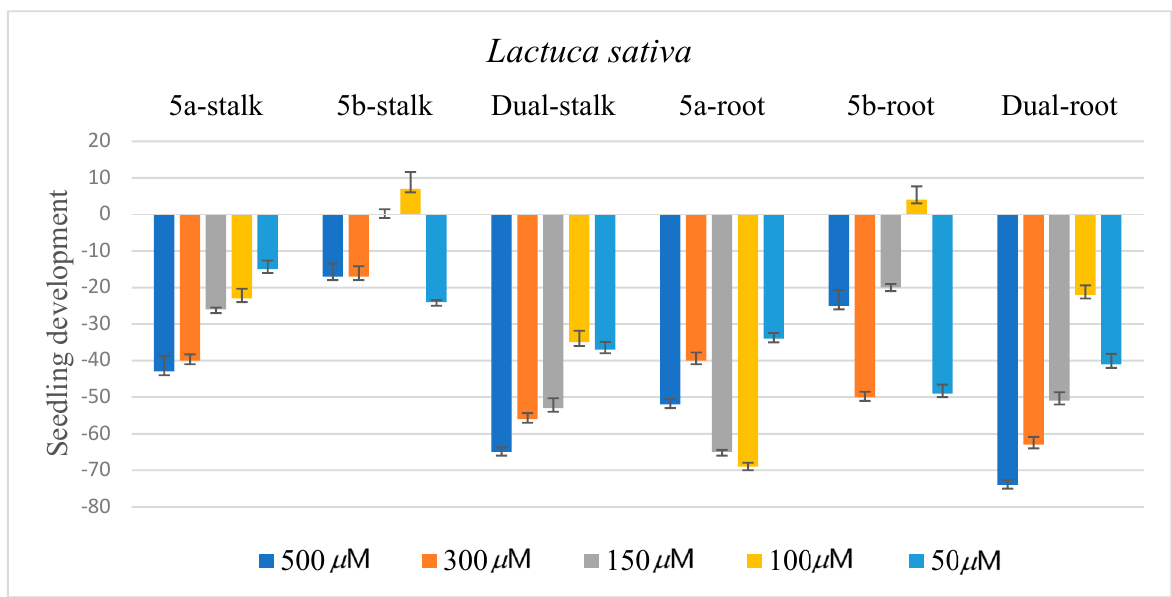
Figure 4. Development of Lactuca sativa ( Dicotyledonae ) seeds in relation to the positive control Dual. Assessing the development of the aerial and root parts of cucumber seeds (Figure 5), all substances interfered with their development; however, none of the tested substances presented satisfactory results compared with the commercial herbicide.